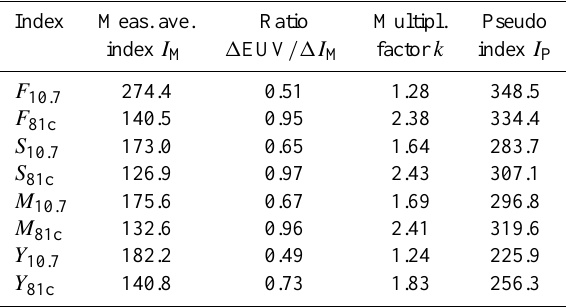
Table 4. Solar indices as daily average values for F 10.7 , S 10.7 , M 10.7 and Y 10.7 and 81-day average values for F 81c , S 81c , M 81c and Y 81c (column 2). Columns 3–5 show the calculated ratios 1 EUV /1I M , the multiplication factors k , as well as the resulting pseudo indices, representing the maximum of the X17.2 flare event.